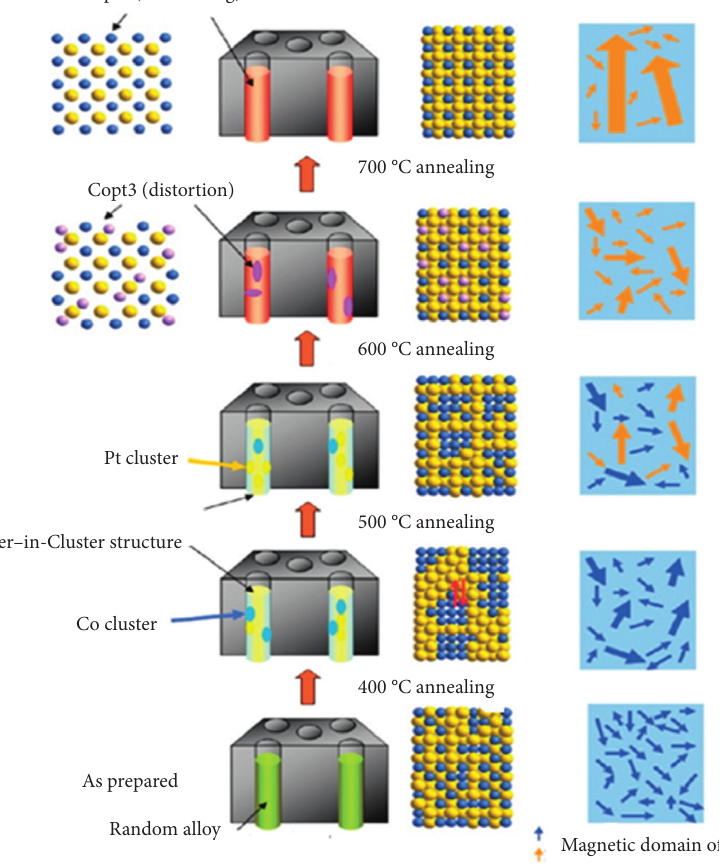
Figure 3: Schematic of the phase conversion steps of CoPt